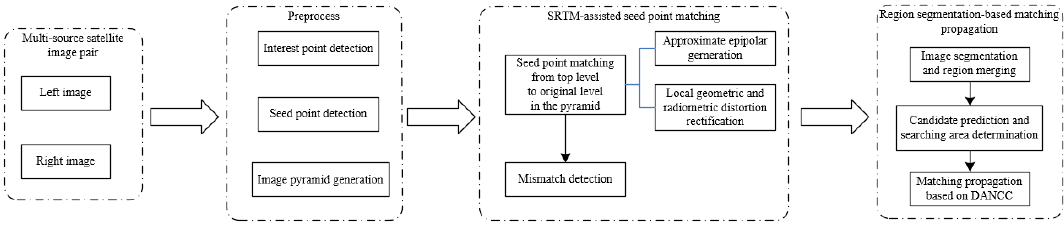
Figure 2. The framework of the proposed matching algorithm. DANCC, Distance, Angle and Normalized Cross-Correlation.